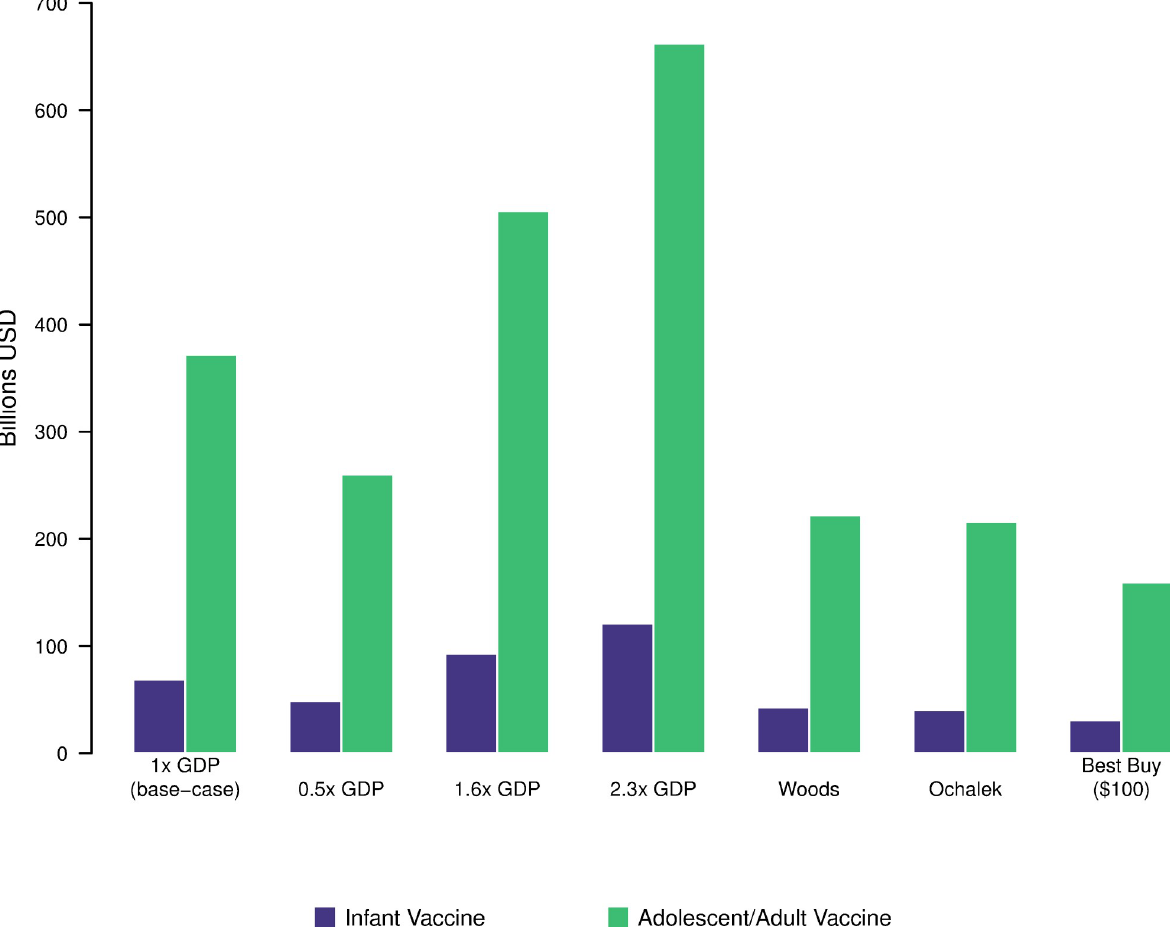
Fig 3. Incremental net monetary benefit of novel tuberculosis vaccines assessed from the societal perspective, for several willingness-to-pay thresholds. Note: Estimates include the iNMB from the countries that are cost-effective at the respective threshold [29–31]. GDP per capita estimates from 2020. GDP, gross domestic product per capita; iNMB, incremental net monetary